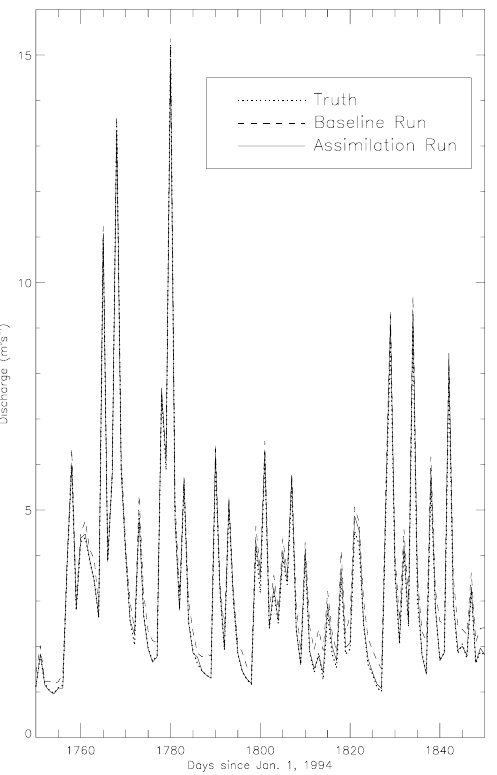
Fig. 8. Comparison of the estimated discharge from the baseline run and the assimilation run with the bias-aware EnKF to the true discharge for a selected part of the simulation